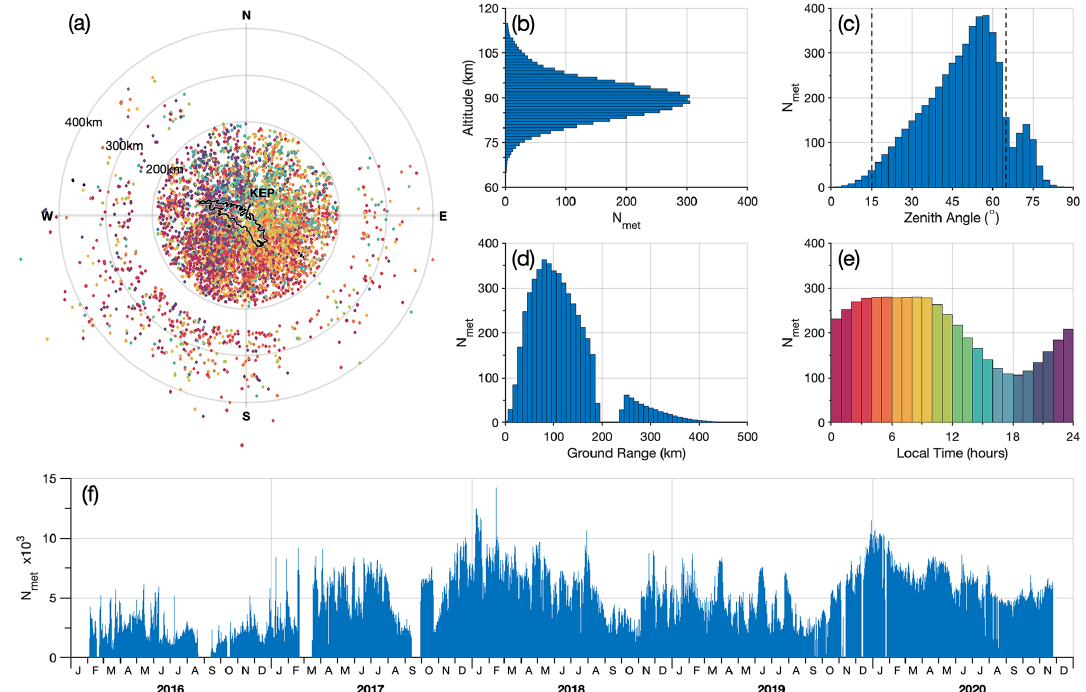
Figure 1. Distributions of meteor echoes detected over King Edward Point (KEP) on South Georgia. Panel (a) shows the horizontal distribu- tion of meteor echoes on 21 June 2018, where echoes are coloured according to their time of detection (see e for colour scale), whereas (b) , (c) , (d) and (e) show histograms of the average height, zenith angle, horizontal (ground) range, and local time of all detected meteor echoes respectively per day for all operational days. Panel (f) shows the number of meteor echoes detected per day for each day of operation during 2016 to